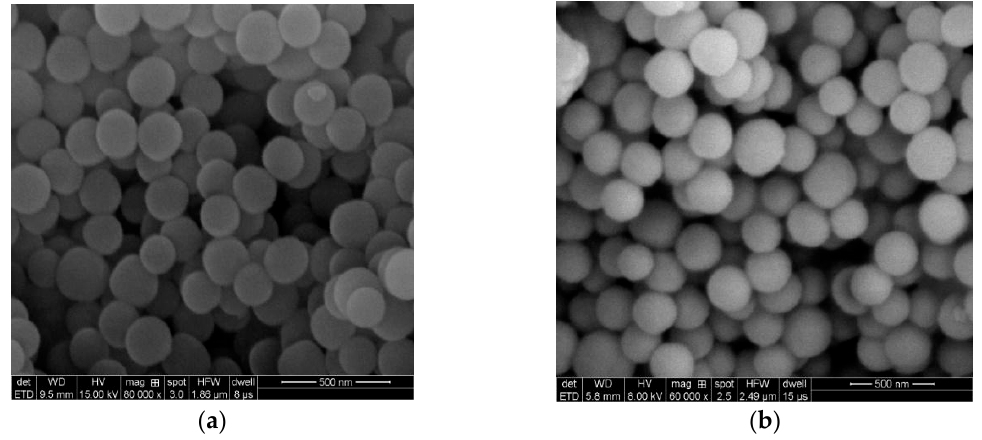
Figure 3. SEM images of the ( a ) RBS-doped silica microspheres, and ( b ) dual-emission silica microspheres.